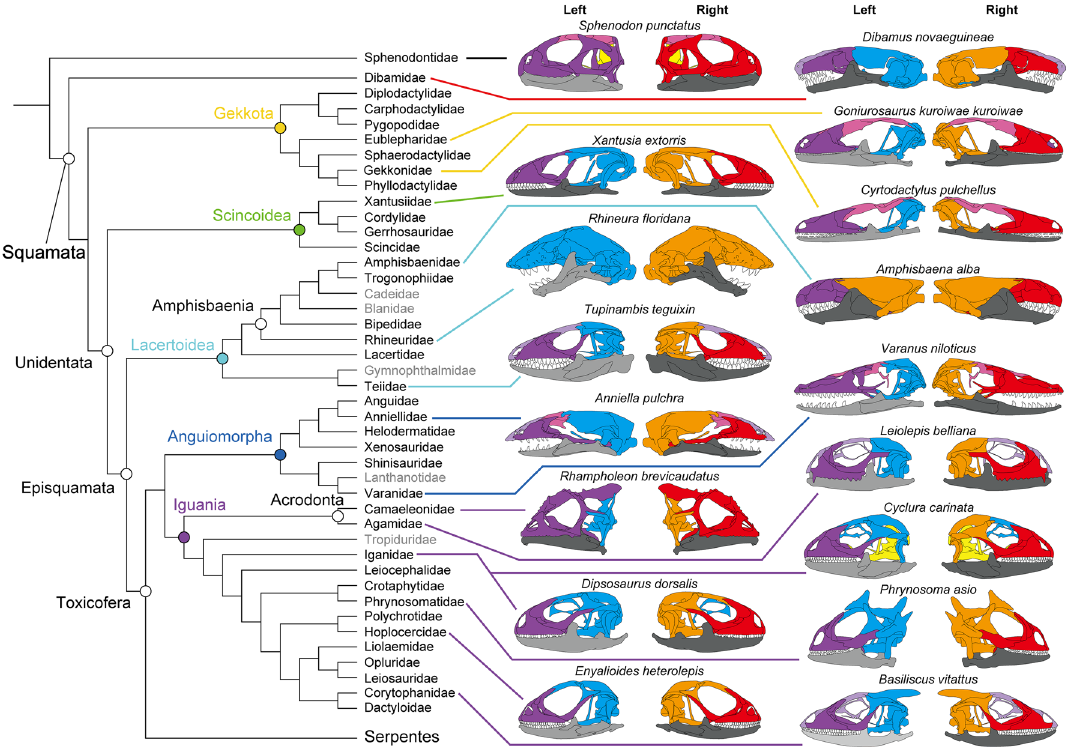
Figure 1. Distribution of skull modules in tuatara and selected lizards from left and right side with the phylogenetic tree. The phylogenetic tree on the left is based on the molecular phylogenetic information in Pyron et al. 49 . Families not covered in this study are grayed